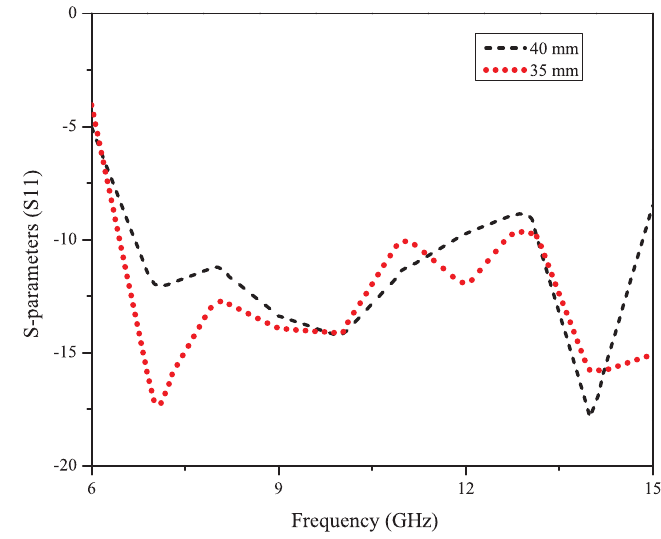
Figure 4. Effect of tapering on reflection parameter.